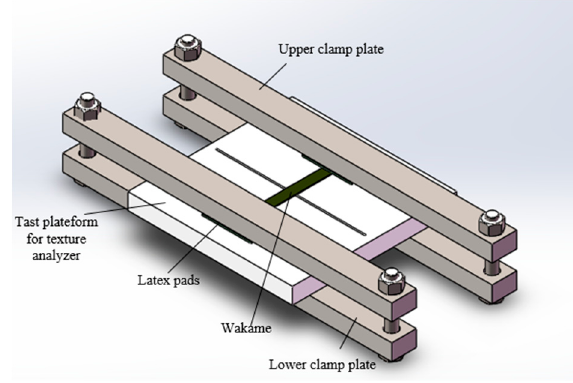
Figure 8. Self-made shearing fixture.